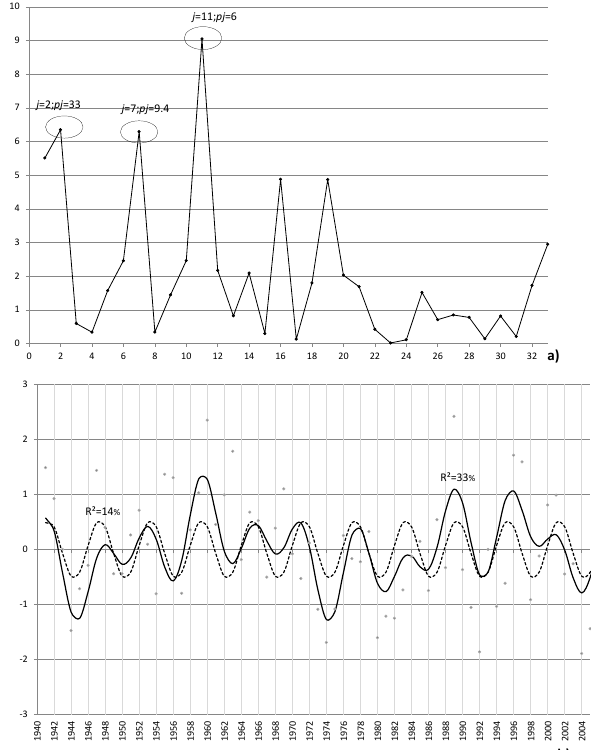
Figure 2. Reguengos: (a) graph of I j , j = 1 ,..., 33; (b) SPI De- cember values (grey dots) vs. fitted sinusoidal wave of 6-year period (dashed line) vs. fitted model resulting from summing up the waves with period 6, 9.4 and 33years (black